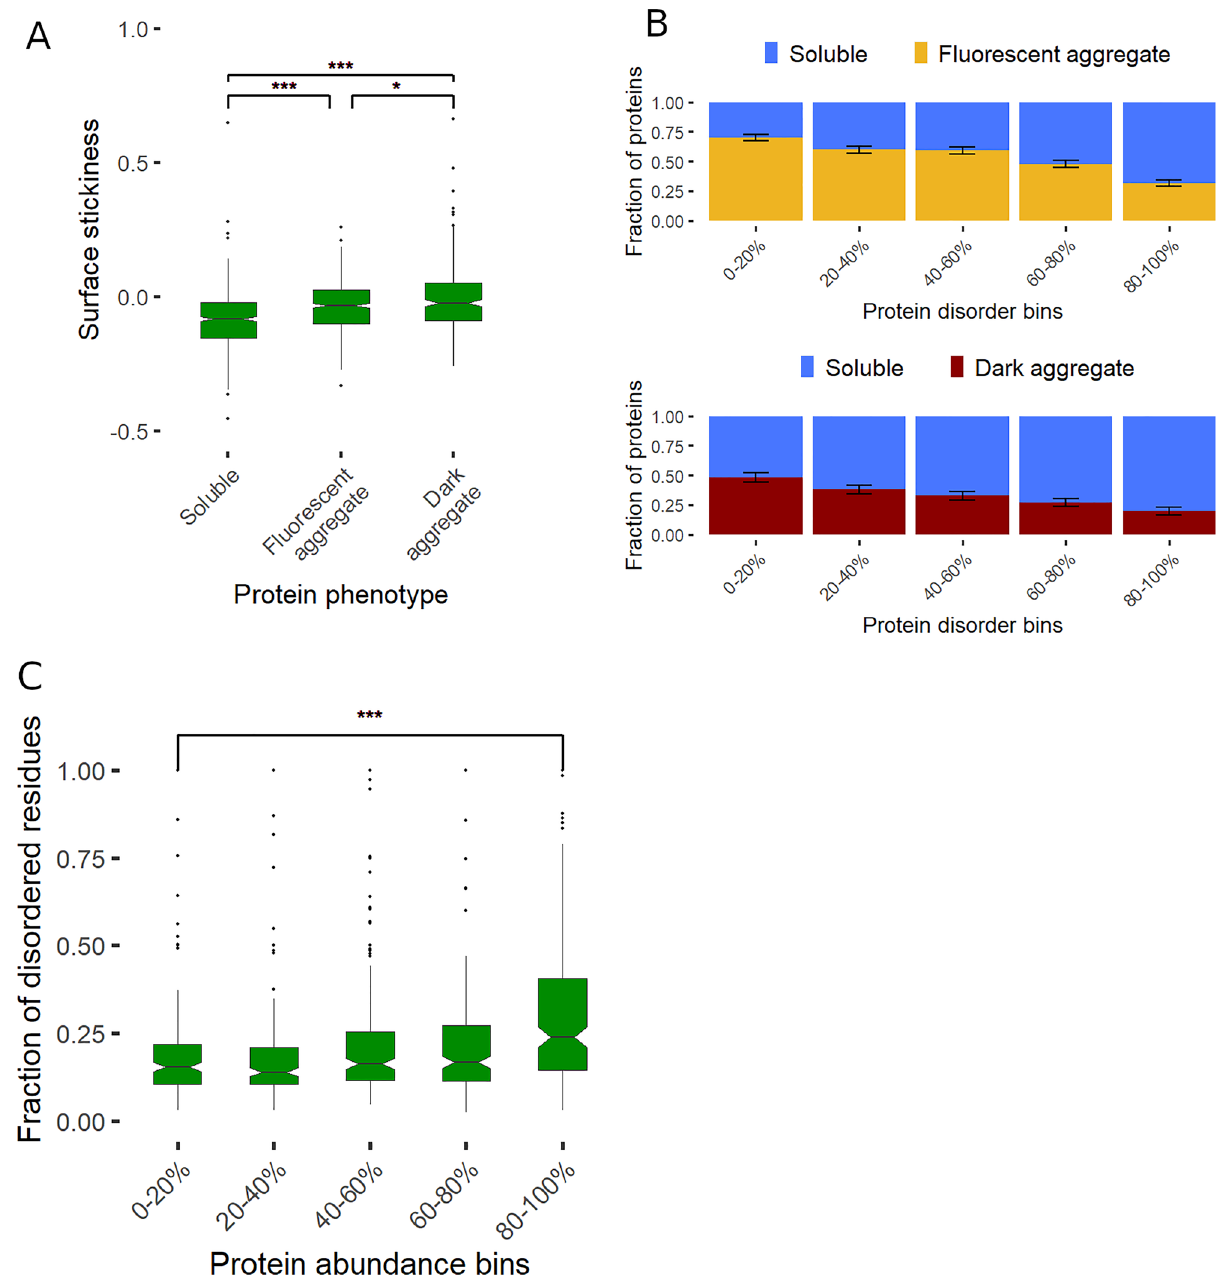
Figure 5. Protein stickiness and disorder content shape solubility. ( A ) We use the surface stickiness score to measure promiscuous interaction propensity 38 . Both fluorescent and dark aggregates show higher surface stickiness than soluble proteins (P < 10 –10 and P < 10 –10 respectively, Wilcoxon Rank Sum test). ( B ) Fractions of aggregating proteins as a function of disorder content (binned data), calculated using PONDR VSL2B. Upper panel shows the fraction of proteins in fluorescent aggregates among those that are either soluble or in fluorescent aggregates, while the lower panel shows the fraction of proteins in dark aggregates among those that are either soluble or in dark aggregates. ( C ) Disorder content as a function of native protein abundance in E. coli based on 41 . The most abundant 20% of E. coli proteins have a significantly higher disorder content than those in the least abundant 20% bin (P = 4.18*10 –11 , Wilcoxon rank sum test). Disorder content was calculated using PONDR VSL2B, but similar results are obtained with other predictors (see Tables S6 and